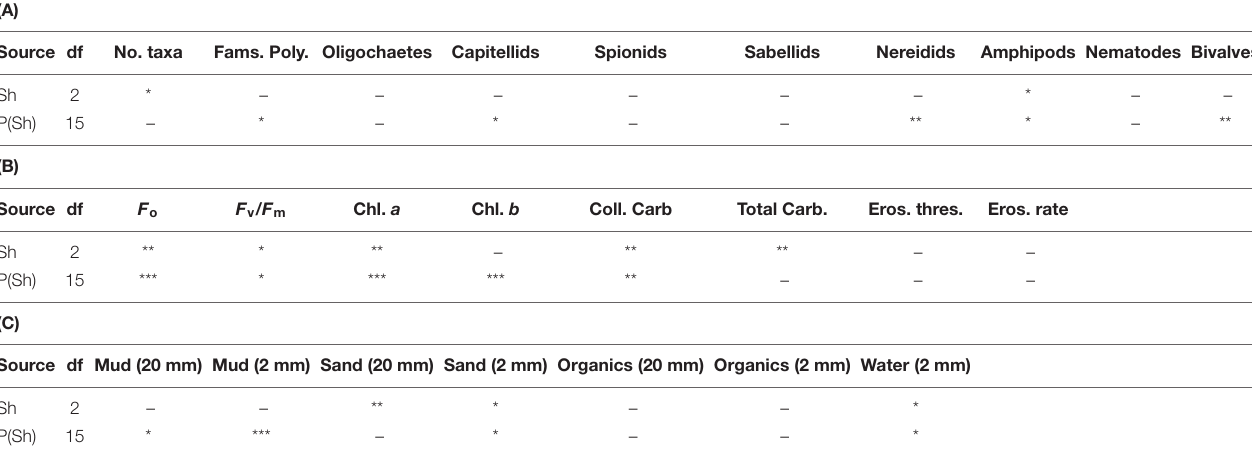
TABLE 2 | Analyses of major components of fauna and selected properties of sediments in plots (P) subjected to Shading (Sh), with appropriate control treatment; experiment 2 at Tambourine Bay after 3 months; details in text.